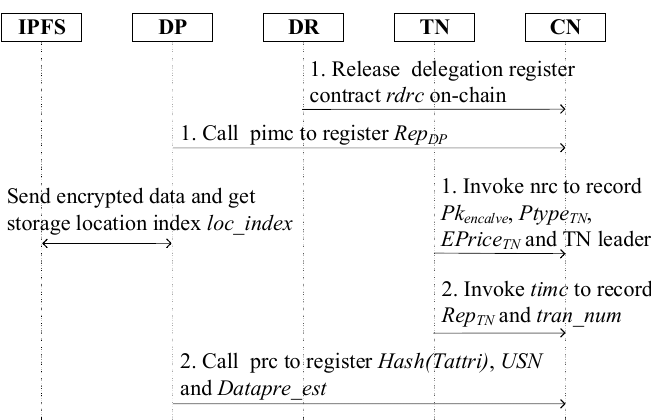
Figure 3. The register phase of SPPCS.